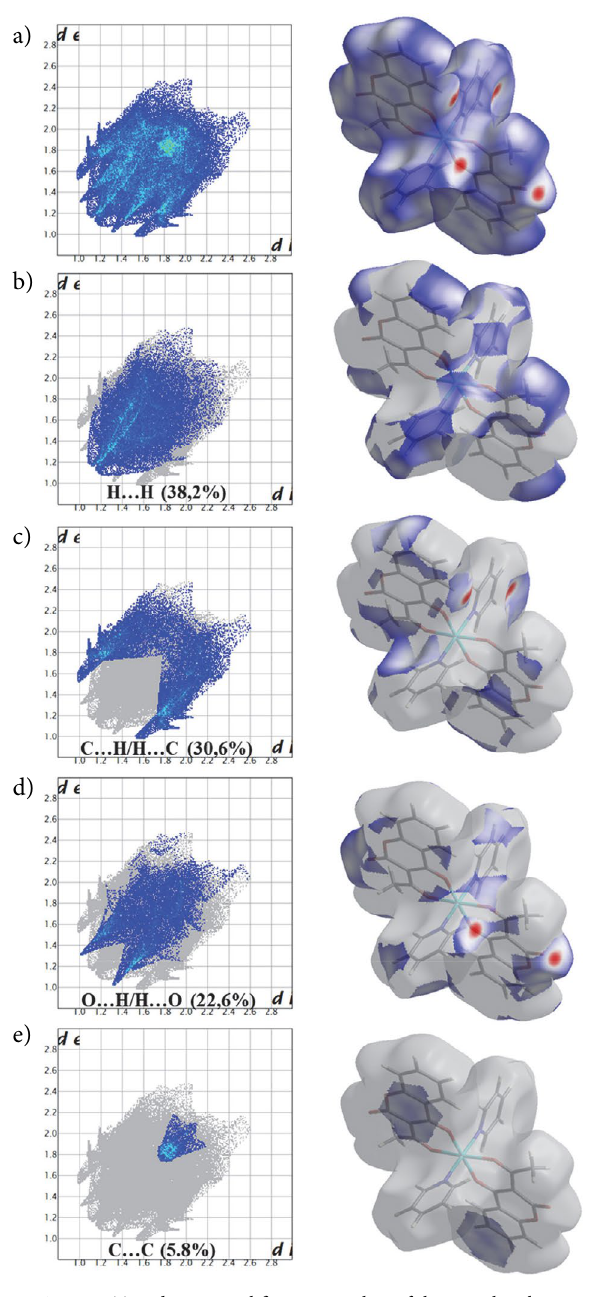
Figure 9. Two-dimensional fingerprint plots of the complex show- ing percentages of contacts contributing to the total Hirshfeld sur- face area of the molecule: ( a ) all interactions, and delineated into ( b ) H ∙ ∙ ∙ H, ( c ) C ∙ ∙ ∙ H/H ∙ ∙ ∙ C, ( d ) O ∙ ∙ ∙ H/H ∙ ∙ ∙ O and ( e ) C ∙ ∙ ∙ C